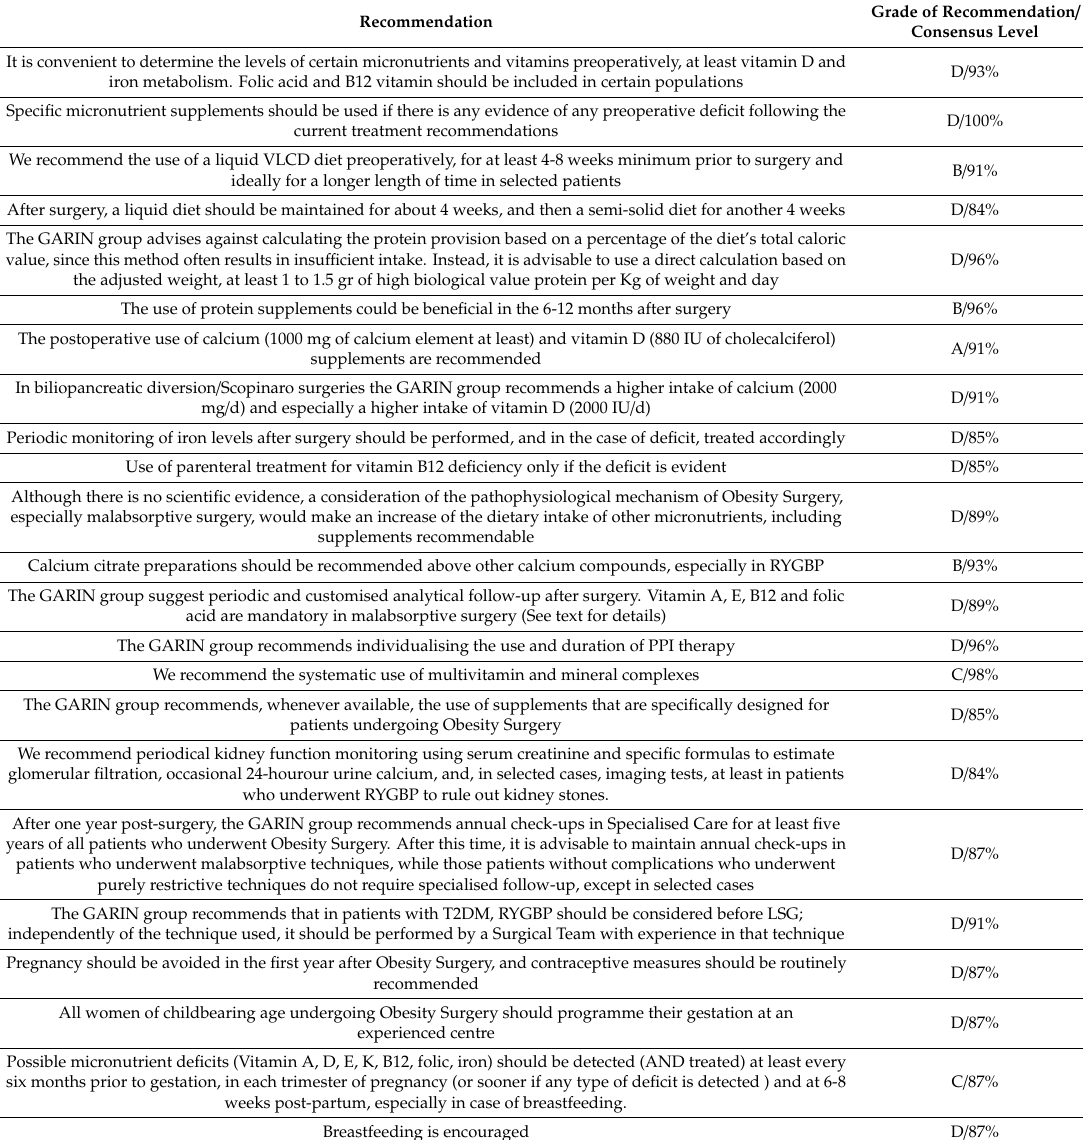
Table 7. Final recommendations / suggestions reached in the present